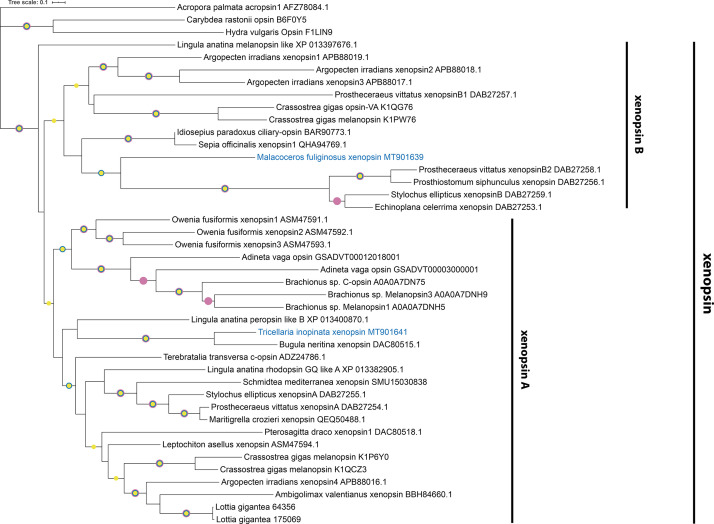
Xenopsin tree rooted with few cnidops.Maximum Likelihood analysis (IQ-TREE, LG+F+I+G4). Labeled nodes have support values of approximate Bayes test ≥0.98 (yellow dot), SH-like approximate likelihood ratio test ≥90 (blue dot), and ultrafast bootstrap ≥90 (purple dot). The sequences investigated in this study are highlighted in blue.